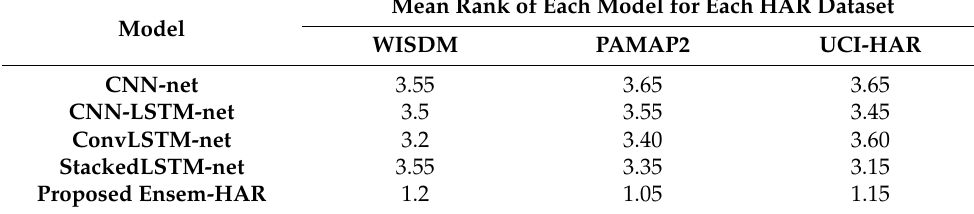
Table 4. Mean ranks assigned to the four base models and the proposed Ensem-HAR model, accord- ing to their accuracies on ten different subsets of each HAR dataset. Mean Rank of Each Model for Each HAR Dataset Model WISDM